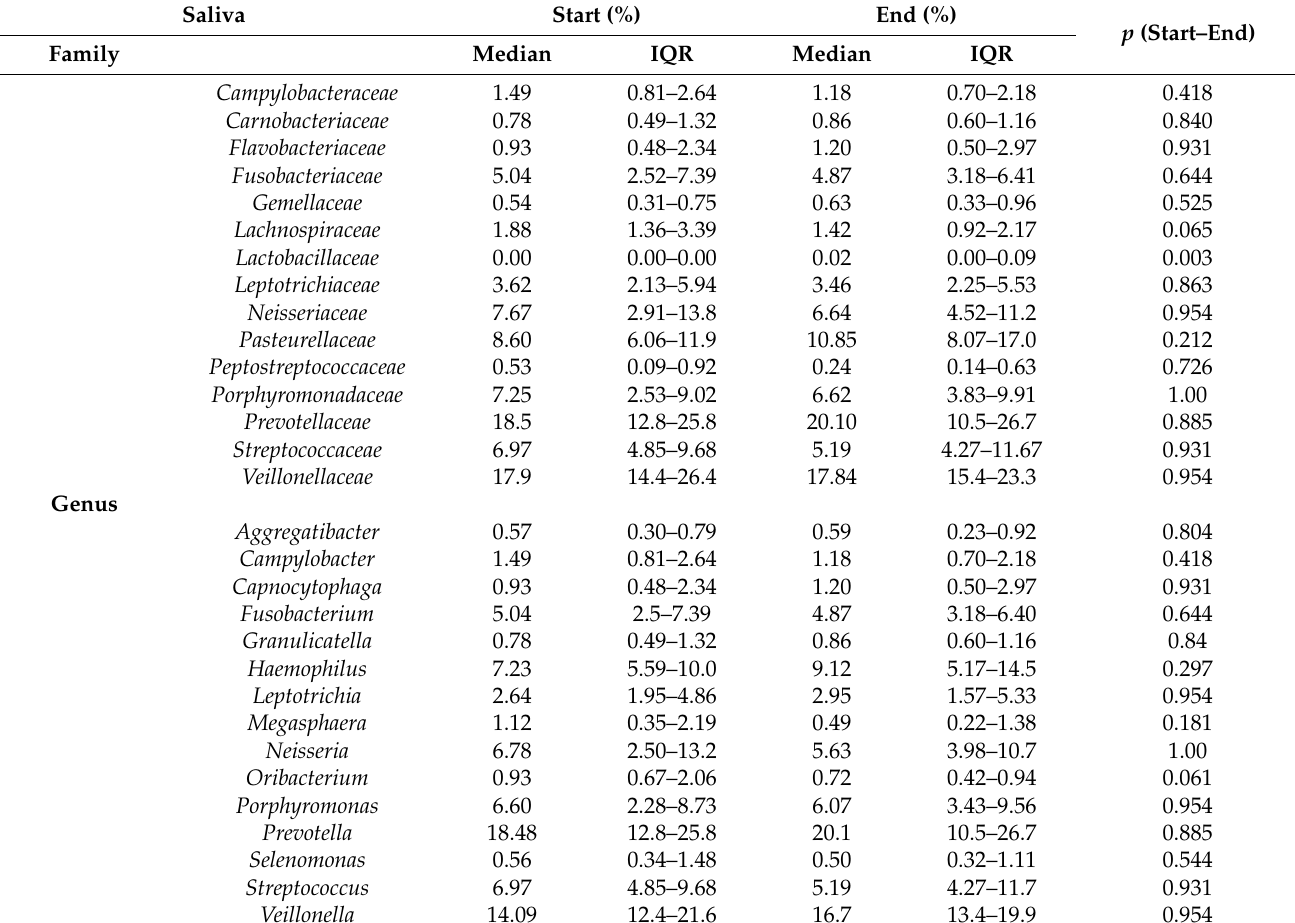
Table 5. Relative abundance of families and genera in saliva samples expressed as median and interquartile range (MD and IQR) at the start and end of the